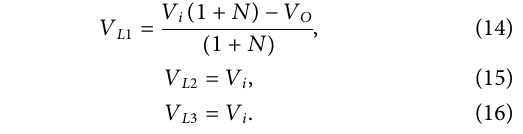
Mode 6: as Figure 3F depicts, initially S 1 and S 3 are turned ON, and S 2 is turned OFF. Current from the battery fl ows through the winding L 1 and switch S 1 , and through the winding L 3 and switch S 3 . The battery current also conducts L 2 , D 2 , L C1 , D 4 , C, and the load. The voltage equation is given as